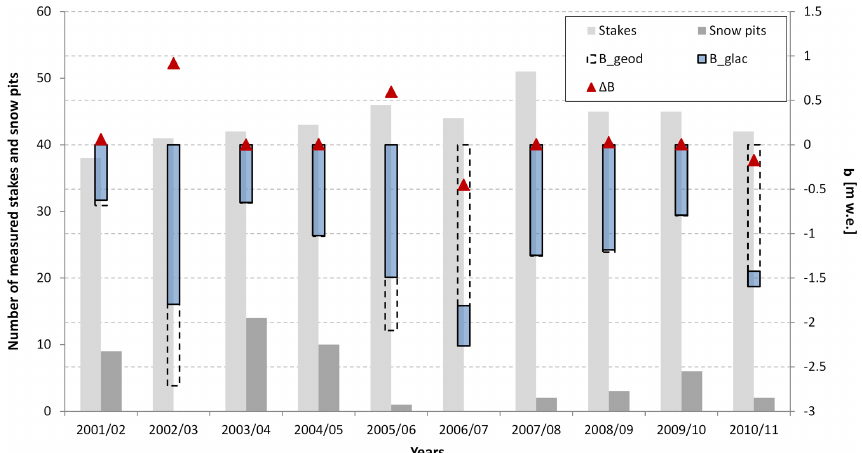
Figure 6. Comparison of mass balances (B glac . hom and B geod . corr ) and their differences ( (cid:49)B ) with number of ablation and accumulation measurements. Note that in areas higher than 3000ma.s.l. only accumulation measurements were